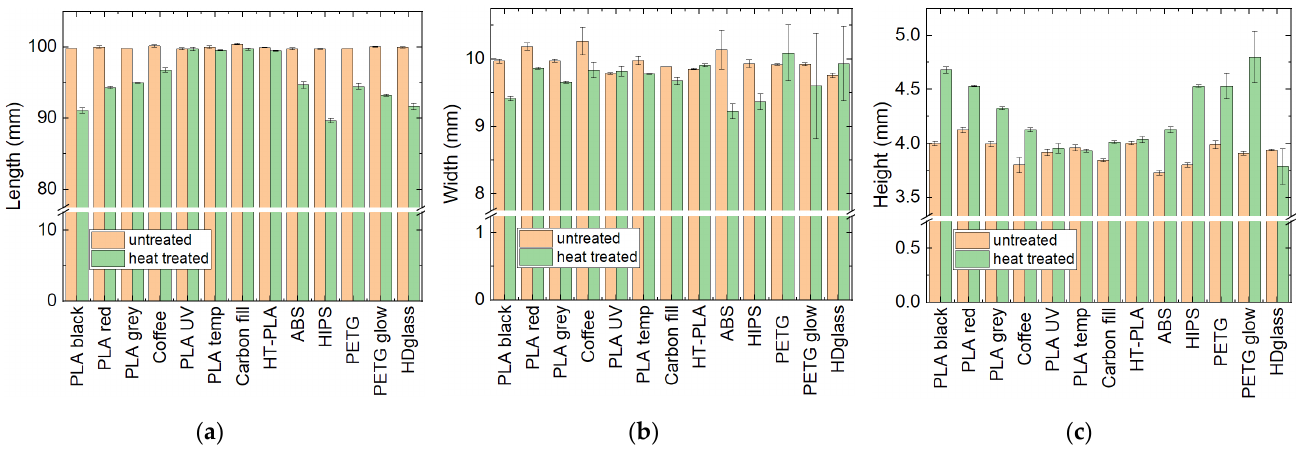
Figure 1. Dimensions of the heat-treated samples: ( a ) length; ( b ) width; ( c ) height. In all graphs, error bars indicate standard deviations.